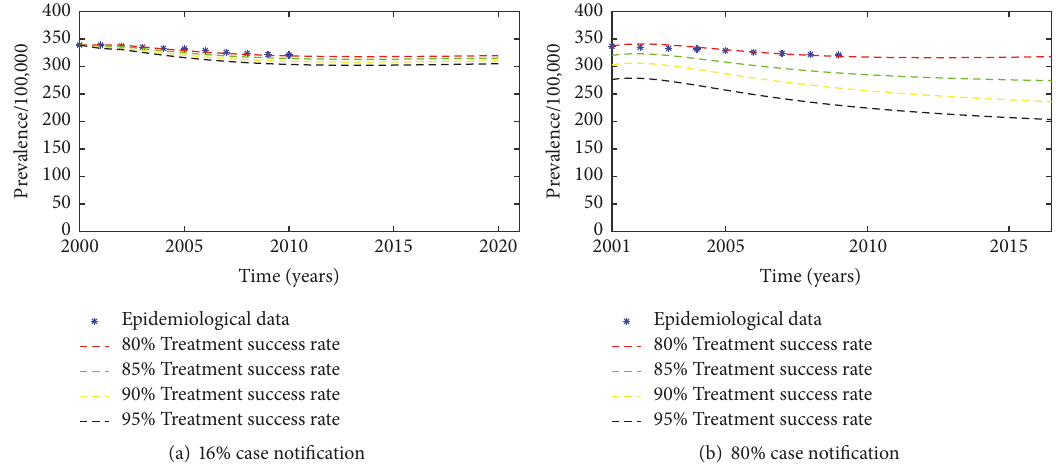
Figure 5: Hypothesis 2: effective treatment in the population with good surveillance and poor surveillance. (a) The figure depicts a relative increase in effective treatment from 80%, 85%, and 90% to 95% in a population with poor case detection, where the notification rate is only 16%. (b) The figure shows a significant decrease in prevalence due to increase in effective treatment from 80%, 85%, and 90% to 95%, in a population with very good case detection, where the notification rate is 80%.